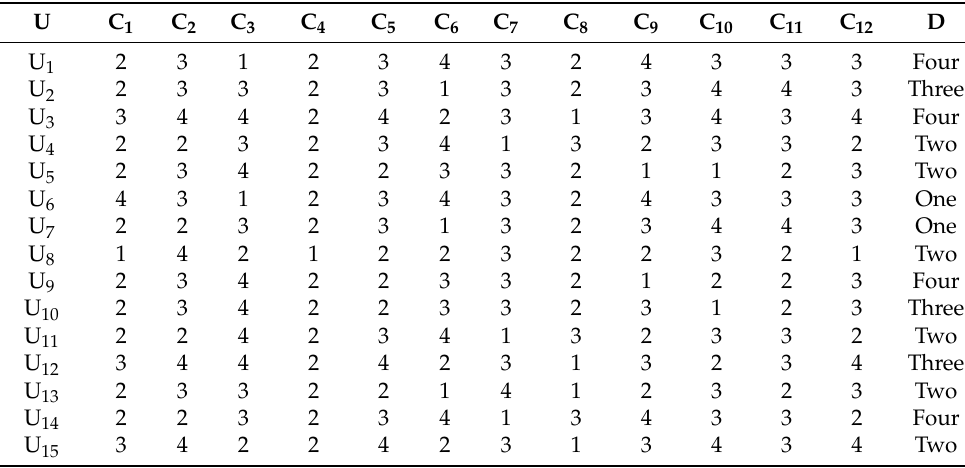
Table 5. Decision table of index rating decision